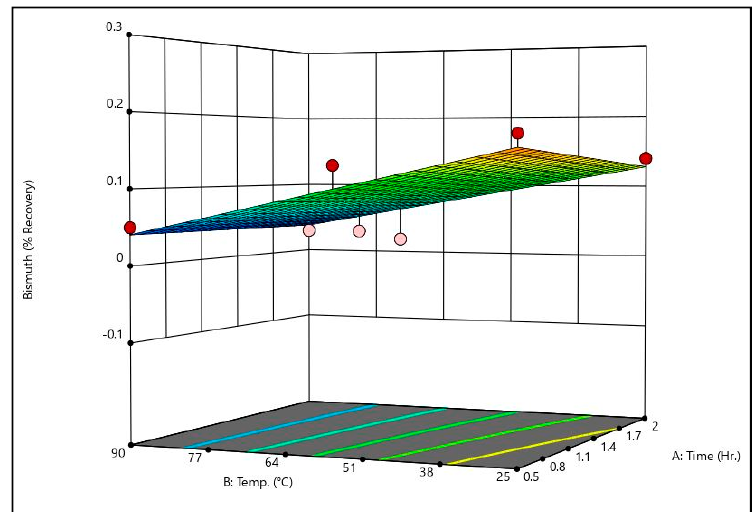
Figure 14. Water leach bismuth recovery response surface.